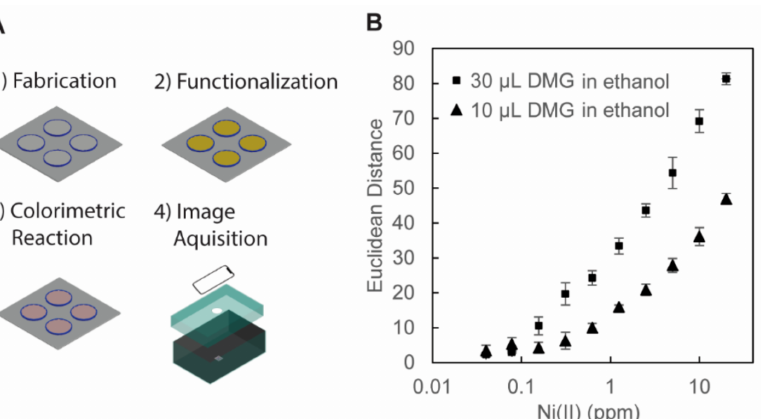
Figure 5. ( A ) Illustration of the procedures for the colorimetric assay of Ni (II) ion. (1) Fabrication: the 3D-PAD was fabricated by FDM printing. (2) Functionalization: the surface of the wells of the 3D-PAD was functionalized with 3-aminopropyl triethoxysilane (APTES) and dimethylglyoxime (DMG) dissolved in ethanol. (3) Colorimetric Reaction: aqueous solutions of Ni (II) ion were added in the 3D wells and dried in an oven, and pink DMG–Ni (II) complexes were formed. (4) Image Acquisition: the device was placed in a blackened carton box for the observation. The images of the 3D-PAD were taken with an iPhone XR camera for analysis. ( B ) Plots showing the color intensity